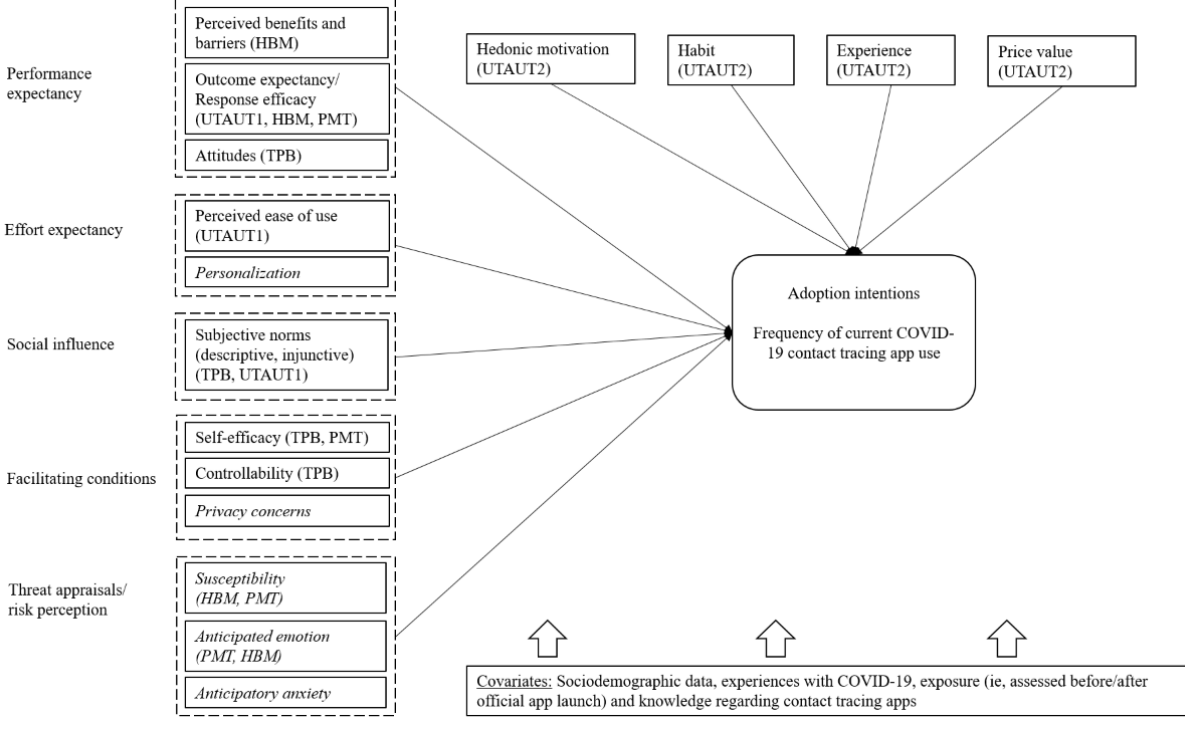
Figure 3. Research framework combining health behavior theories (health belief model [HBM], protection motivation theory [PMT], theory of planned behavior [TPB]) and technology acceptance (unified theory of technology acceptance and use 1 and 2 [UTAUT1 and UTAUT2]) to predict